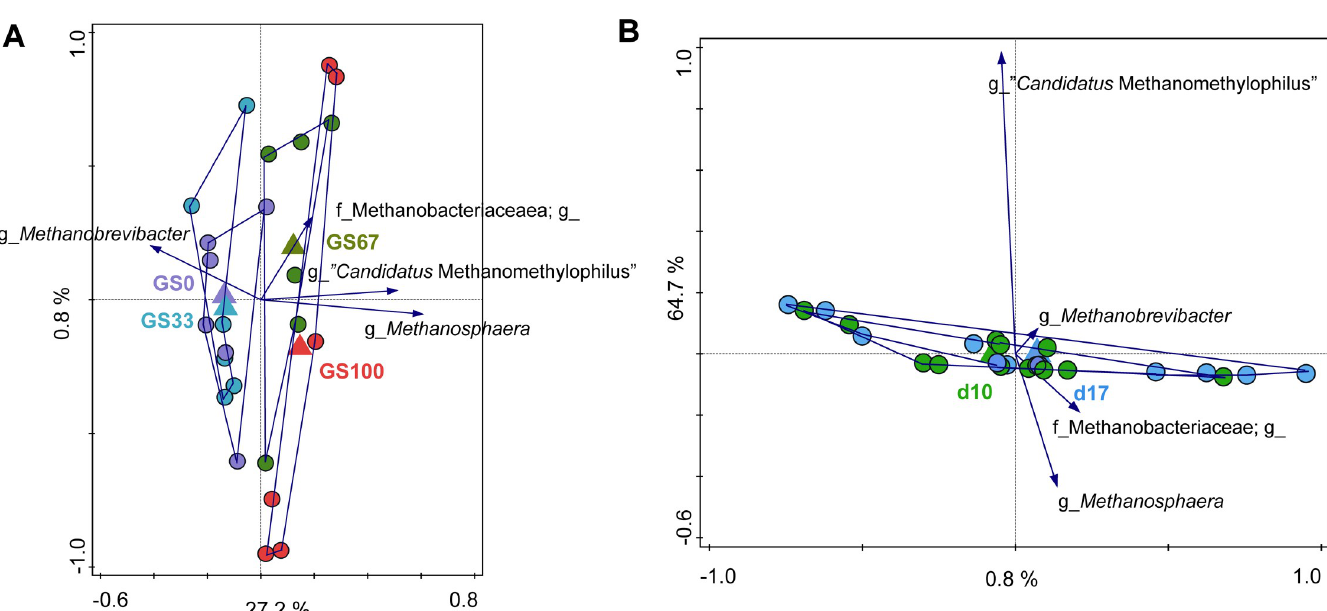
Fig 6. Redundancy analysis of rumen archaeal communities. Redundancy analysis triplots of partial RDA showing the relationship between the top 15 genus level phylogenetic groupings of the OTUs for which the variance is best explained by the constrained axes. Arrow length indicates the variance that can be explained by (A) diet with covariate time and (B) time with covariate diet. The explanation of the plots and the labels for the taxa and samples are as previously described in Fig 3.